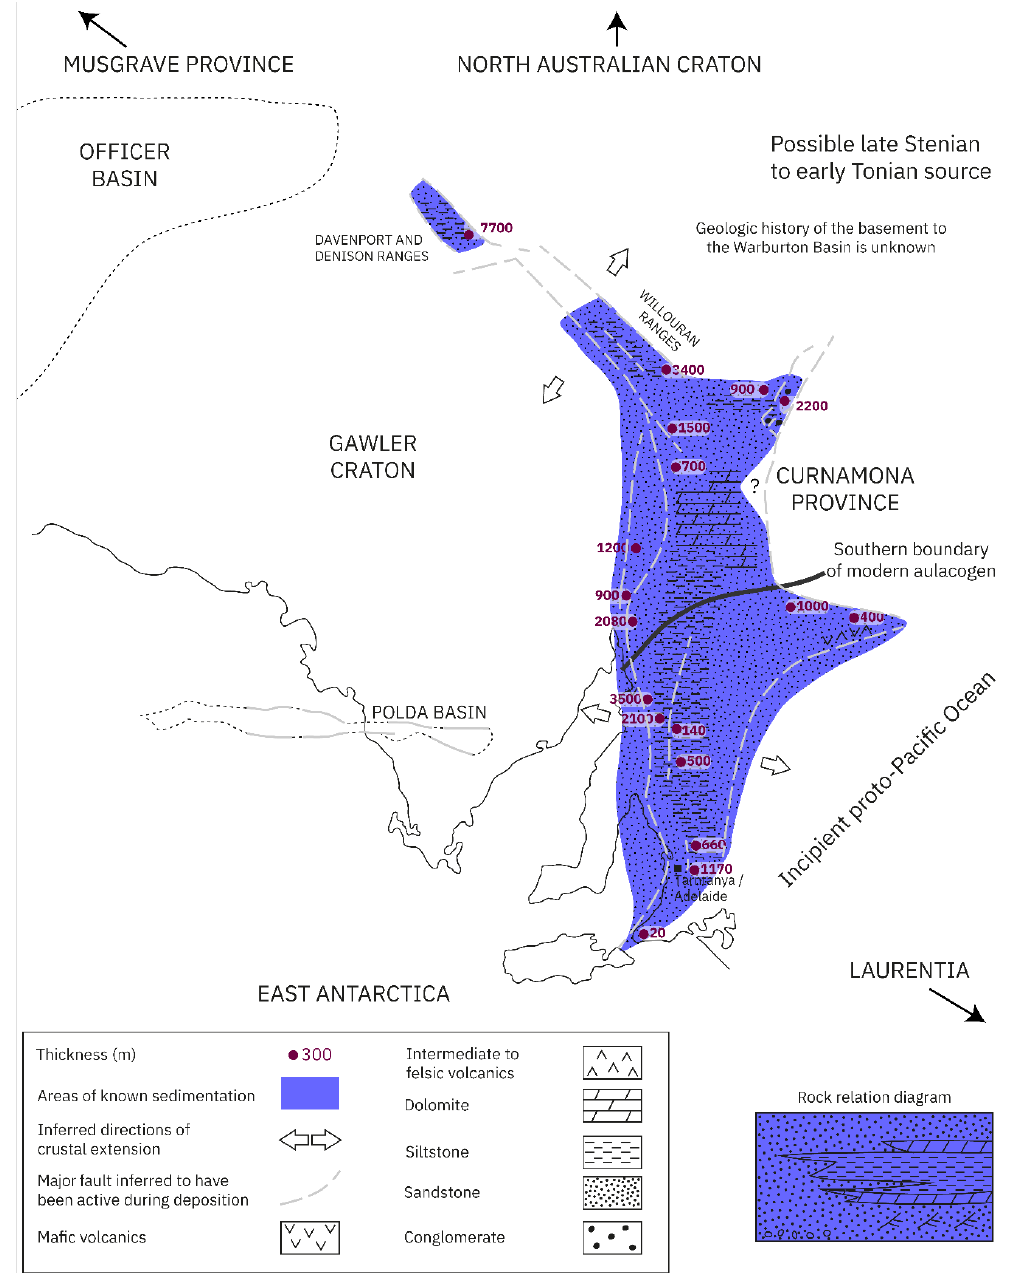
Figure 12. Paleogeographic map showing the known distribution of the Emeroo Subgroup (c. 800–790 Ma) sedimentary deposition, highlighting the southward progression of deposition (and the rift system) in the Adelaide Superbasin. Relative positions of relevant continental blocks in Rodinia are also indicated. Geography of the Adelaide Superbasin is shown in its modern-day configuration, with the modern coastline shown for reference. Adapted from Preiss [41].